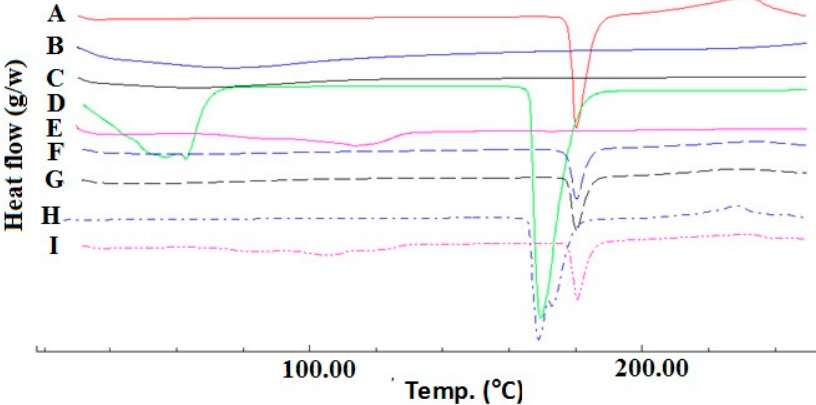
Figure 1. DSC thermograms of SUL ( A ); Prosolv ® ( B ); croscarmellose ( C ); mannitol ( D ); magnesium stearate ( E ) and their respective physical mixture (( F – I ), traces) at 1:1 w / w ratio.